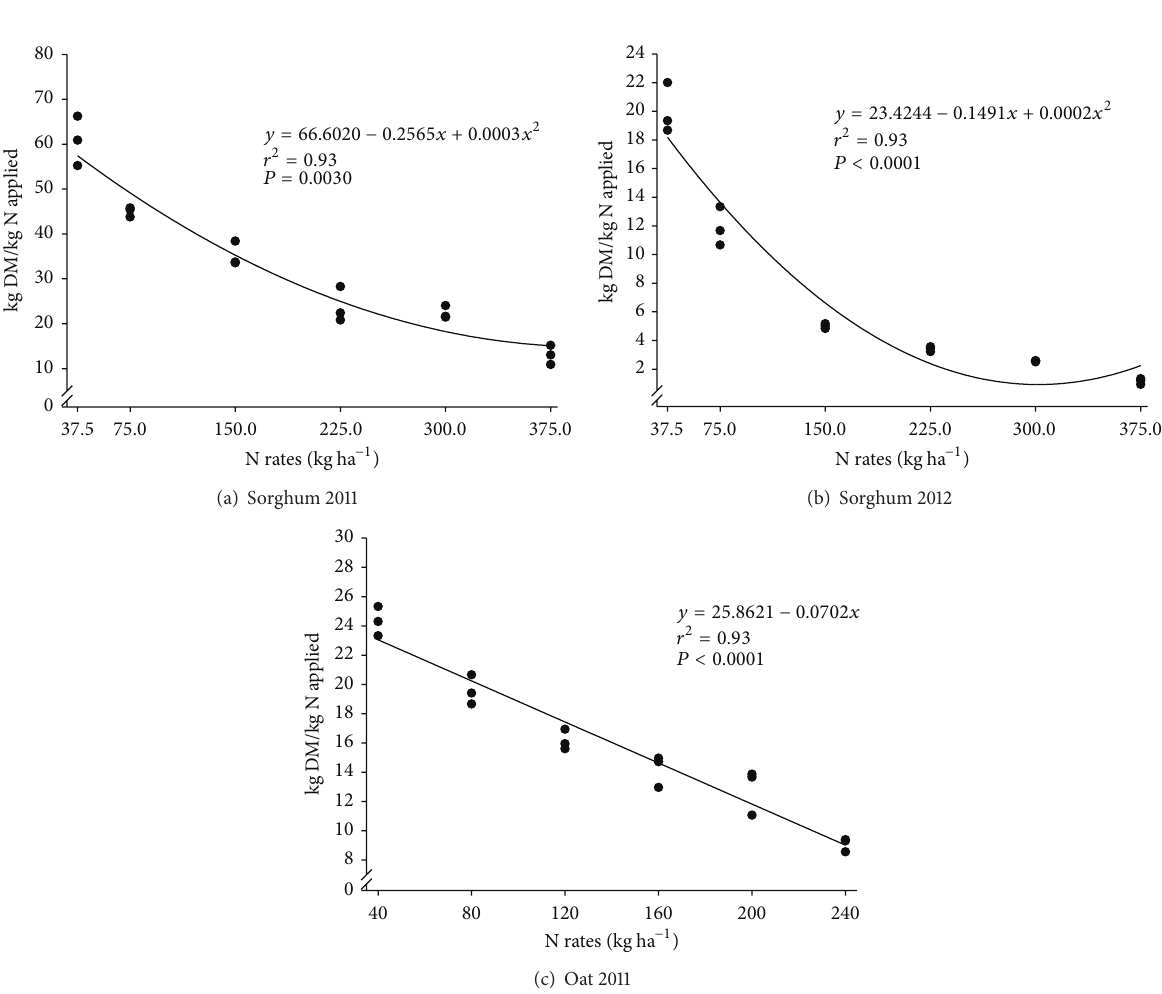
Figure 6: Nitrogen recovery efficiency (kgDM kg −1 N applied) by the forage of sorghum in the summer seasons of 2010/2011 (a) and 2011/2012 (b) and black oat in the winter season of 2011 (c), under nitrogen